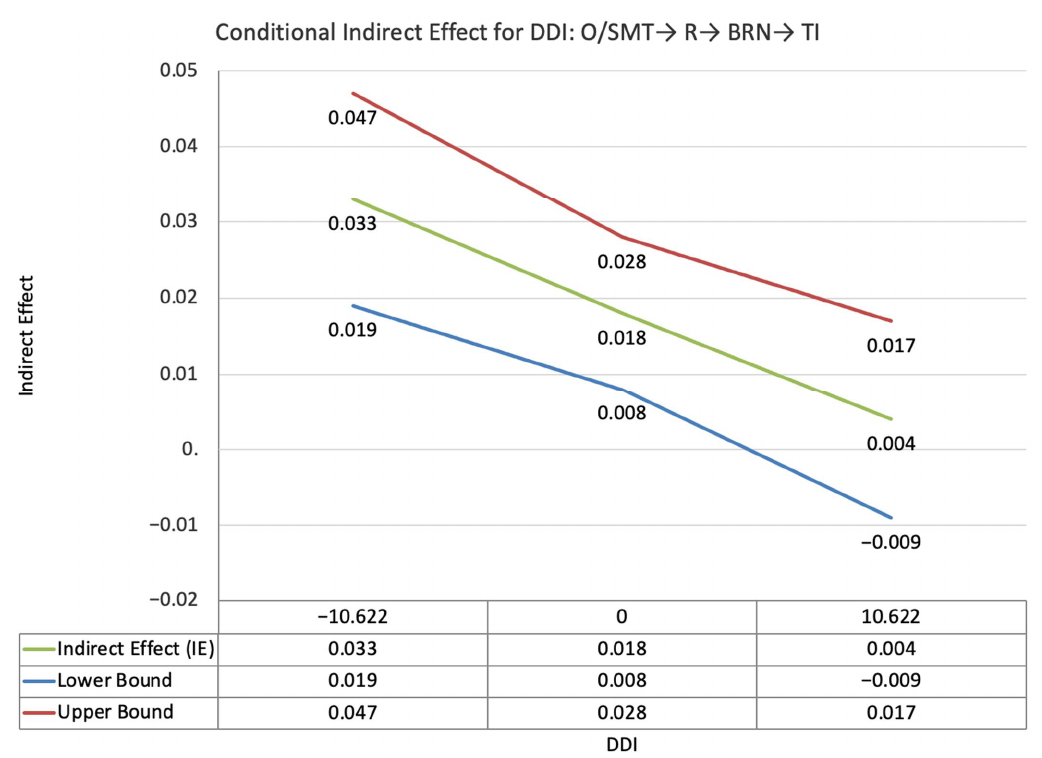
Figure 4. Conditional indirect effects of the difference between other-PMIEs compared to the control group on turnover intentions at low, average and high levels of self-disclosure, through relatedness satisfaction and burnout.